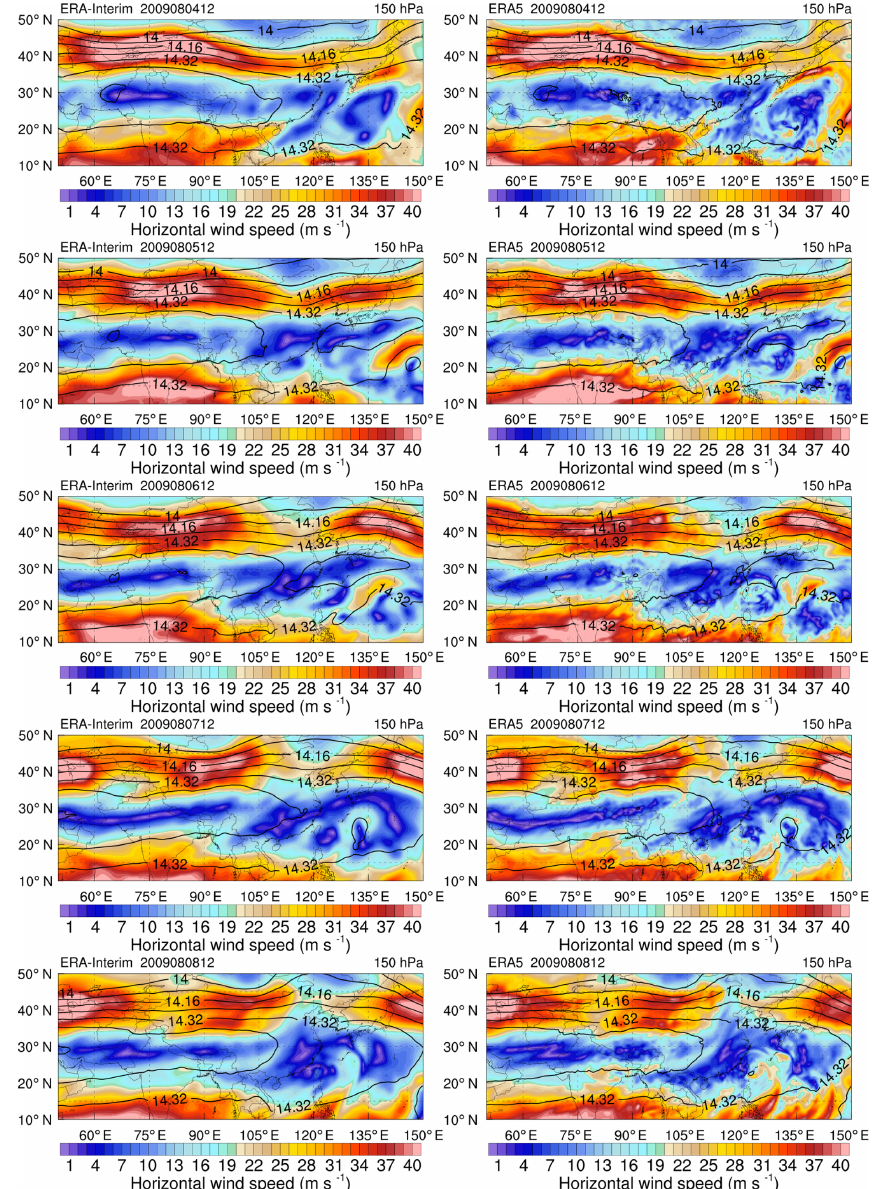
Figure A1. Geopotential height (black lines, gpkm) and horizontal wind speeds (shaded, ms − 1 ) at 150hPa on 4, 5, 6, 7, and 8 August 2009 from ERA-Interim (left) and ERA5